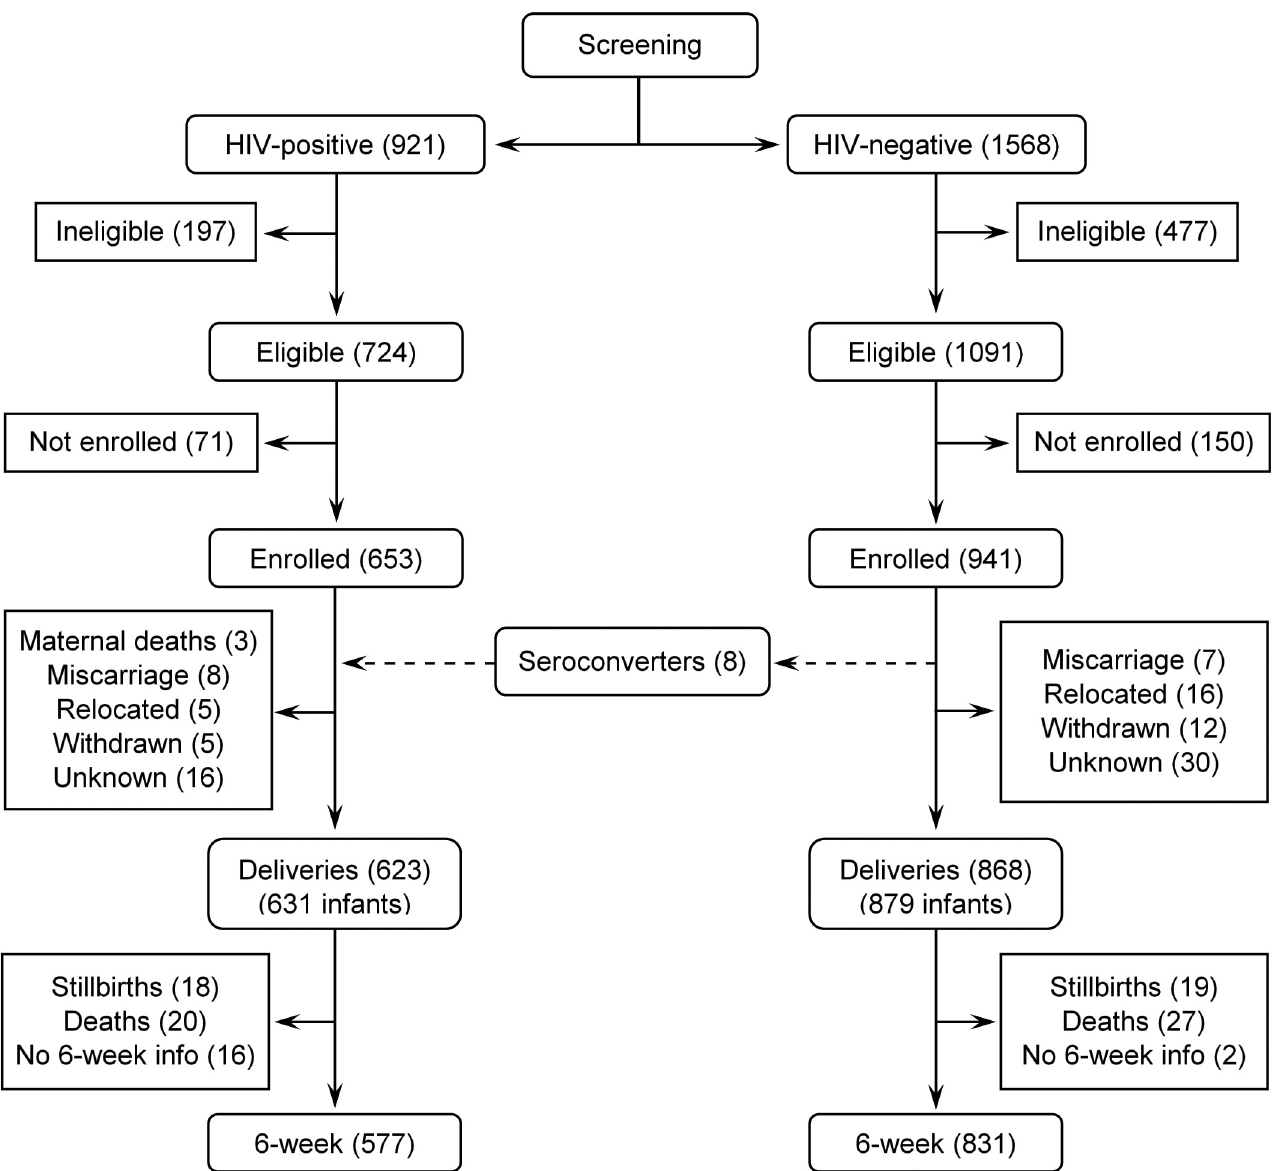
Fig 1. Study enrollment for comparison of 6-week PMTCT outcomes for HEI and HUI in the era of lifelong ART.